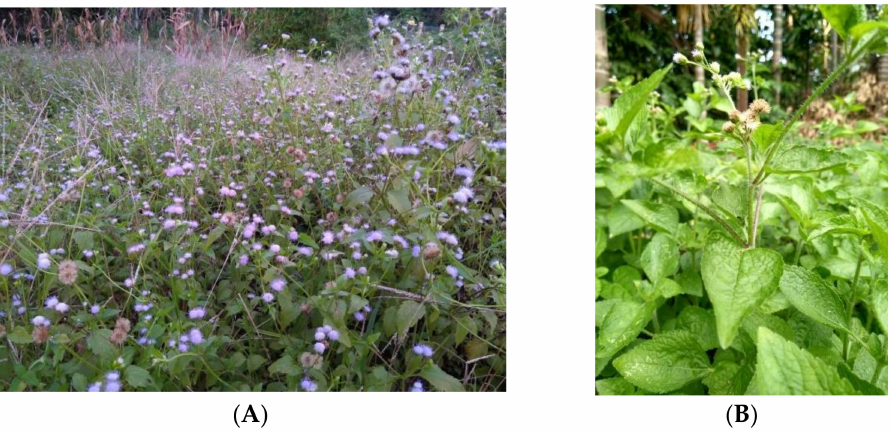
Figure 1. Blooming Ageratum conyzoides L. ( A ), and ( B ) Whole aerial Part. The essential aspect of the bioassay test is to detect the allelopathic action of com- pounds on target species [18,19]. In this study spiny amaranth ( Amaranthus spinosus L.) was selected as the target plant, due to its fast uniform germination and sensitivity and